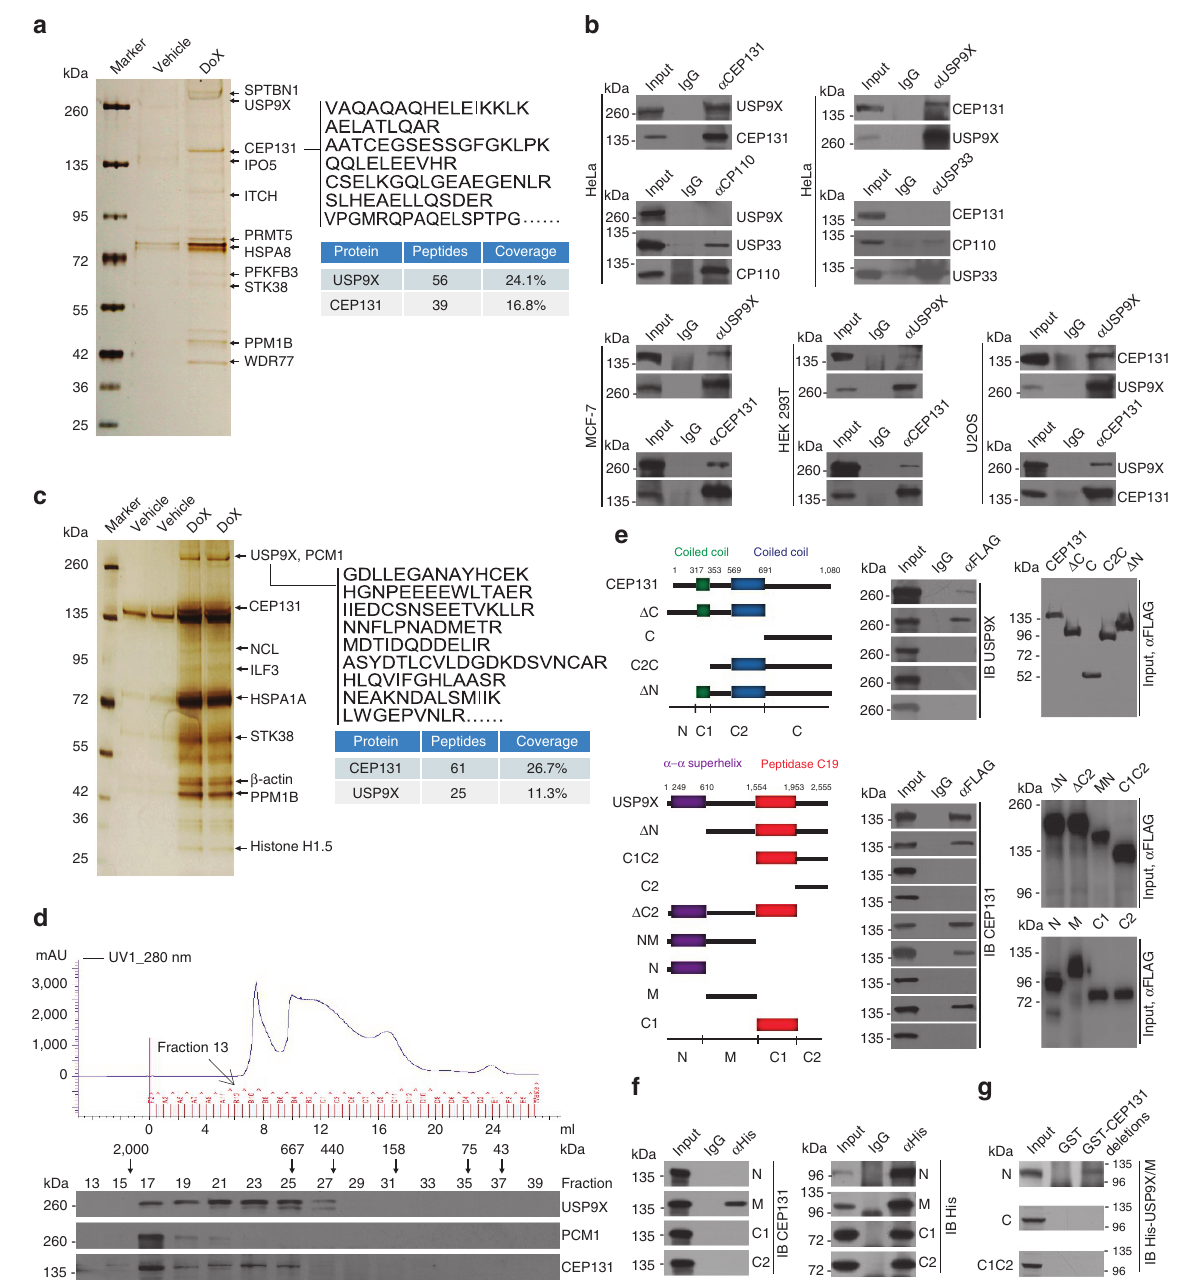
Figure 1 | Deubiquitinase USP9X is physically associated with the centriolar satellite protein CEP131. ( a ) Immunoaffinity purification of USP9X-containing protein complexes. Whole-cell extracts from HeLa cells with Dox-inducible expression of stably integrated FLAG-USP9X were purified with an anti-FLAG affinity column. After extensive washing, the bound proteins were eluted with excess FLAG peptides, resolved and visualized by silver staining on SDS–PAGE. The protein bands on the gel were recovered and analysed by mass spectrometry. Representative peptide fragments of CEP131 and peptide coverage of the indicated proteins are shown. Detailed results from the mass spectrometric analysis are provided as Supplementary Data 1. ( b ) Whole-cell lysates from HeLa, MCF-7, HEK293Tand U2OS cells were immunoprecipitated (IP) followed by immunoblotting (IB) with antibodies against the indicated proteins. ( c ) Immunoaffinity purification of CEP131-containing protein complexes. Representative peptide fragments of USP9X and peptide coverage of the indicated proteins are shown. Detailed results are provided as Supplementary Data 1. ( d ) Whole cellular extracts from HeLa cells were fractionated on Superose 6 size exclusion columns. Chromatographic elution profiles and IB analysis of the chromatographic fractions with antibodies against the indicated proteins are shown. The elution positions of calibration proteins with known molecular masses are indicated, and an equal volume from each fraction was analysed. ( e ) Co-immunoprecipitation analysis of the molecular interface required for the interaction between CEP131 and USP9X. The conserved domains of CEP131 and USP9X were determined by the SMART programme. ( f ) Pull-down analysis of the domains involved in the interaction between USP9X and CEP131 with His-tagged USP9X deletion mutants purified from Sf9 cells and GST-tagged full length of CEP131 purified from bacteria cells. ( g ) Pull-down analysis of the domains involved in the interaction between CEP131 and USP9X with GST-tagged deletion mutants of CEP131 purified from bacteria cells and His-tagged USP9X/M purified from Sf9